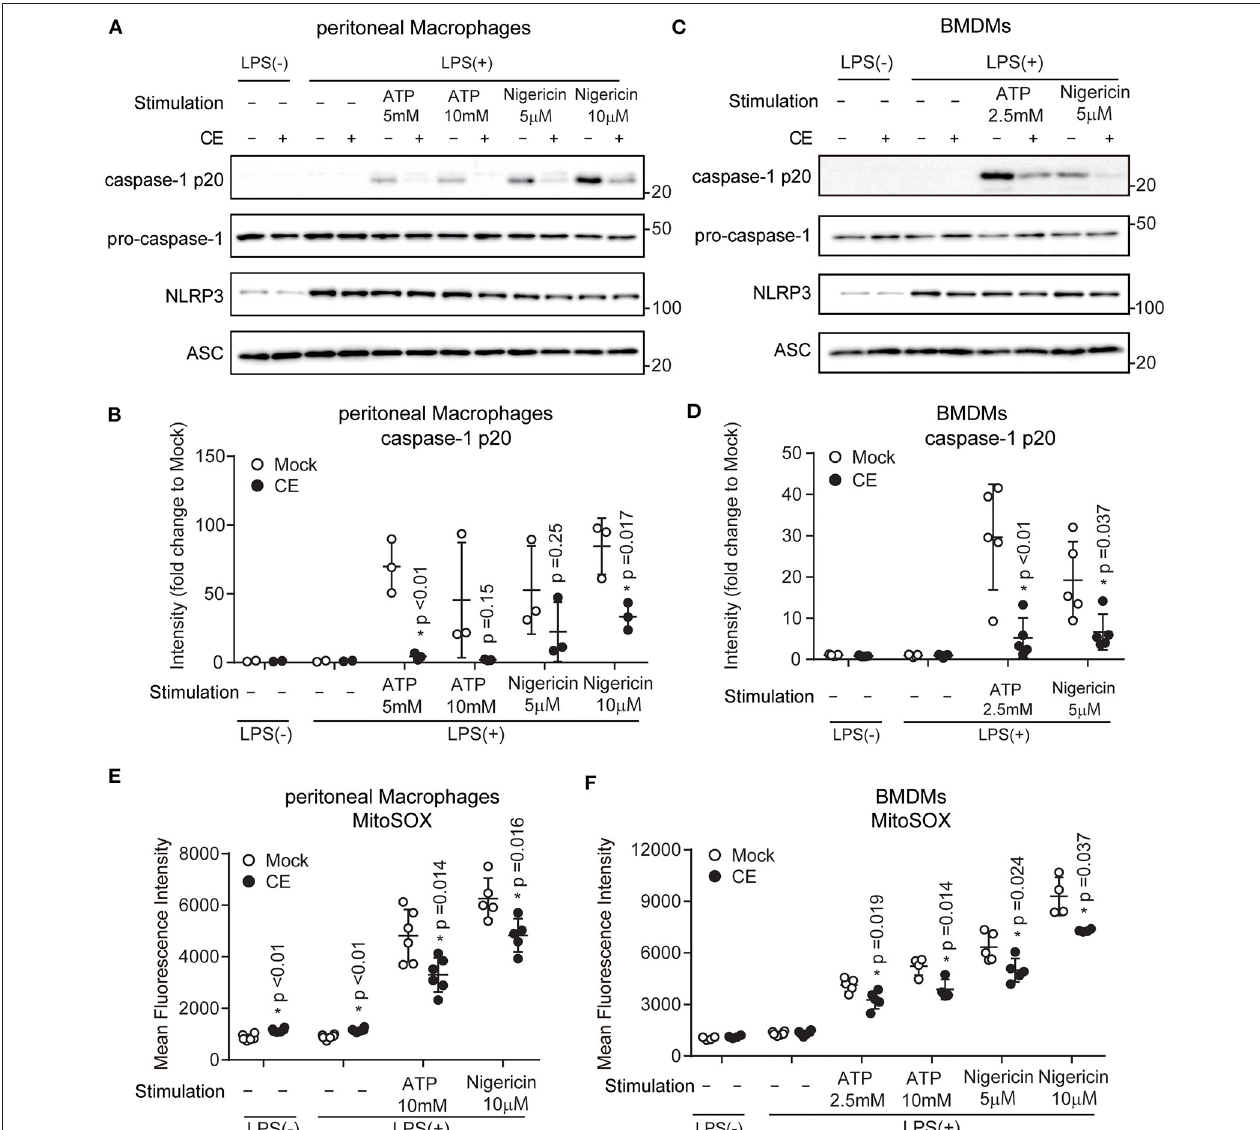
FIGURE 4 | Chlorella extract inhibits mitochondrial ROS in NLRP3 inflammasome activation. (A–F) pMACs and BMDMs were treated with Mock or CE for 16h prior to the addition of 100 (A,B,E) or 10 (C,D,F) ng/mL LPS for 4h before stimulation with ATP or nigericin for 60 (A,B,E) or 30 (C,D,F) min. The protein levels of pro-caspase-1, caspase-1 p20, NLRP3 and ASC were analyzed by western blotting [western blot image (A,C) , quantification (B,D) ]. A representative western blotting quantification of caspase-1 p20 (B,D) was normalized to β -actin expression and relative to Mock only treated group. Cells were stained with MitoSOX Red for 10min and then were analyzed by FACS to measure mitochondrial ROS (E,F) . Error bar show mean ± SEM. * p < 0.05 vs. Mock-treated groups. Data are representative of at least three independent